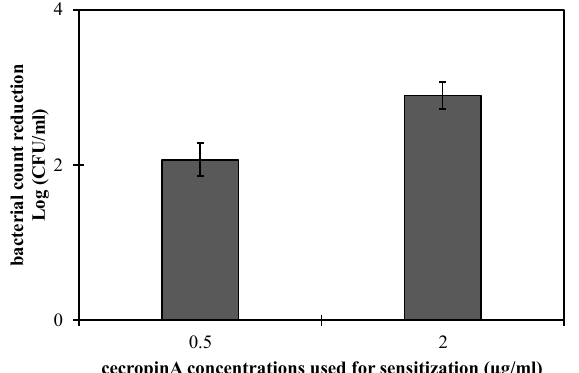
Figure 4. The effect of pre-treating bacterial cells with cecropin A on HEWL antibacterial activity. Salmonella enterica ATCC 35664 was grown till the exponential phase, pelted, and washed twice using 10 mM potassium phosphate buffer. The collected cells were then treated with 0.5 and 2 µg/mL cecropin A for 10 min and washed twice using the same buffer. The sensitized cells were then treated with 500 µg/mL HEWL lysozyme for 1 h at 35 °C. Log reduction in the bacteria count was calculated with respect to the pre-treated cells exposed to buffer instead of HEWL.